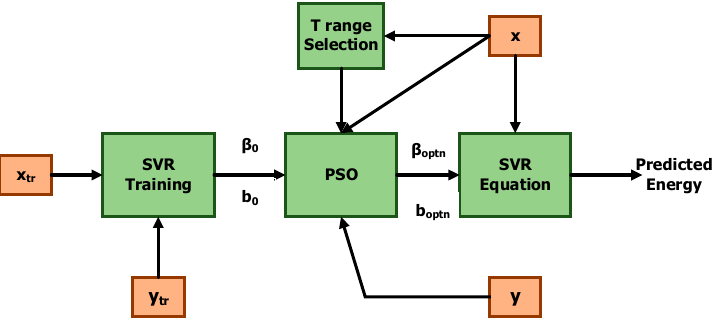
Figure 6. Block diagram of the modified PSO tuned support vector regression-based prediction system.